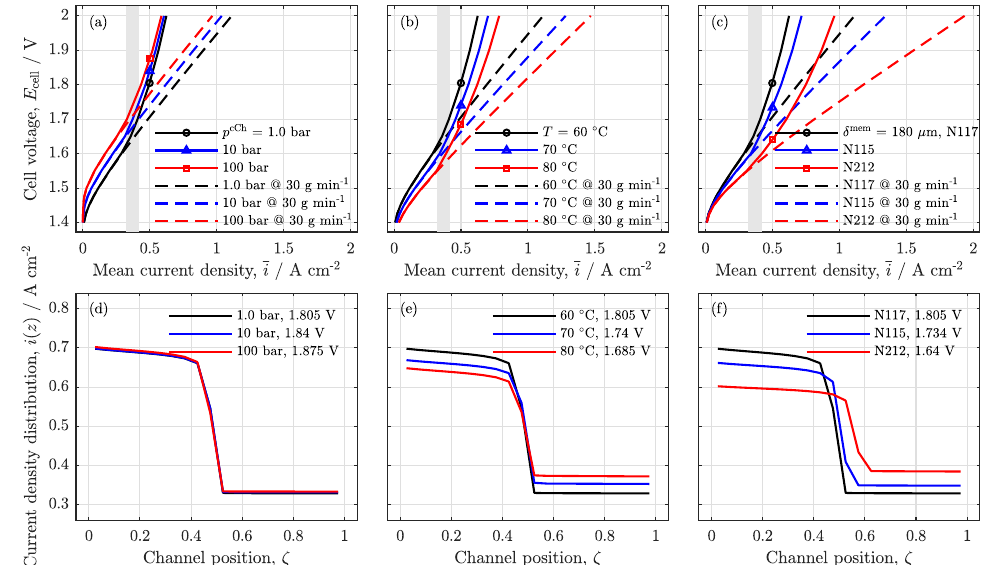
Figure 8. Polarization curves for different operating parameters: ( a ) cathode pressure, ( b ) cell temperature and ( c ) the membrane thickness for a sufficient water flow rate of 30gmin − 1 (dashed lines) and a low water inlet flow rate of 0.4gmin − 1 (full lines). The gray vertical strip indicates the current density range at which the cell starts to dry out. Current density distributions at 0.4gmin − 1 and a mean current density of ¯ i = 0.5Acm − 2 for a variation of ( d ) cathode pressure, ( e ) cell temperature and ( f ) membrane